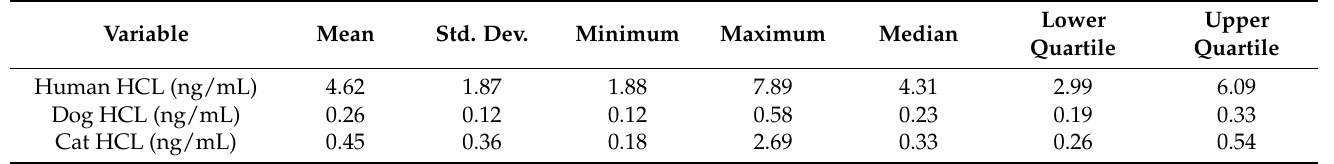
Table 1. Descriptive statistics for human and animal hair cortisol levels (HCL).